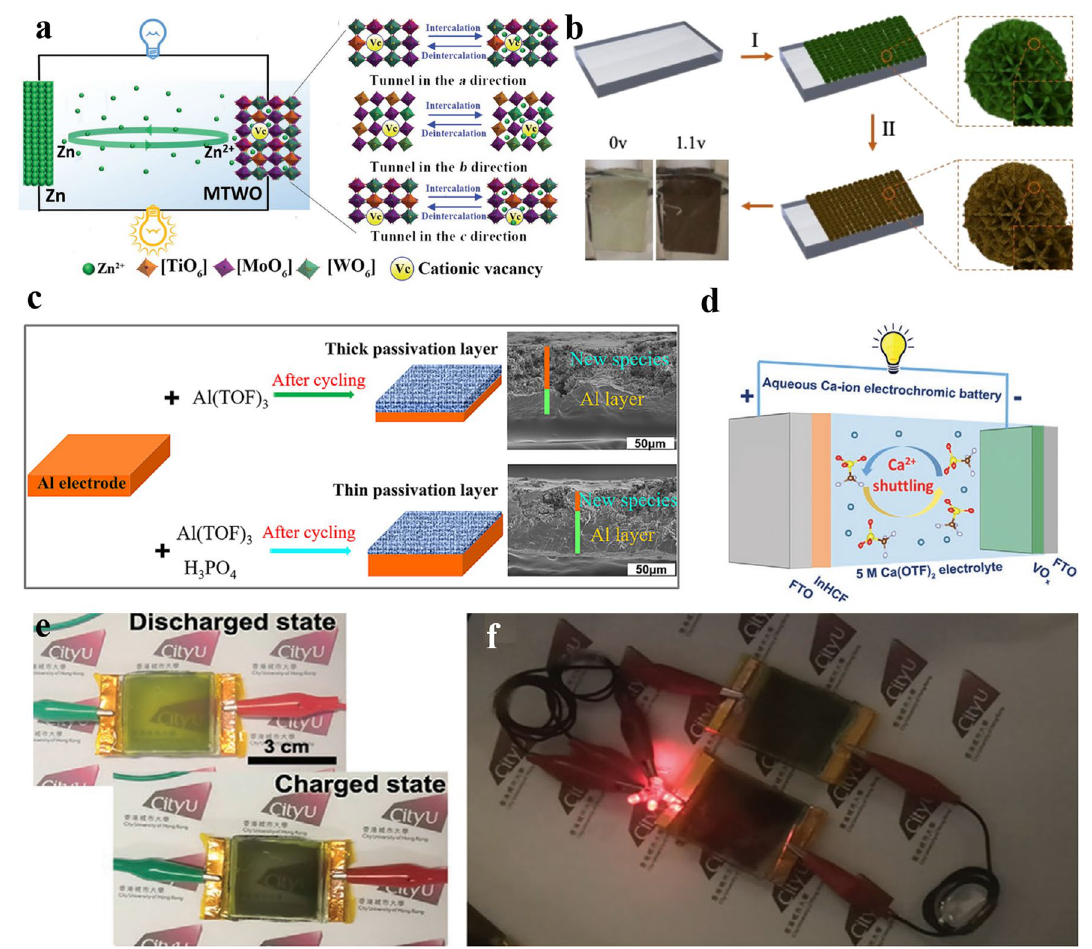
Fig. 7 Progress of multivalent-ion aqueous electrolytes in MERABs. a Schematic illustration of Zn 2+ -based MERABs. Reproduced with per- mission [101]. Copyright 2019, Wiley–VCH. b Preparation procedures of the Ni-MOF open framework. Reproduced with permission [102]. Copyright 2020, American Chemical Society. c Schematic showing the passivation film formation. Reproduced with permission [24]. Copy- right 2021, Elsevier. d Schematic illustration of the Ca 2+ -based MERABs system. Demonstrations of e color modulation, and f powering